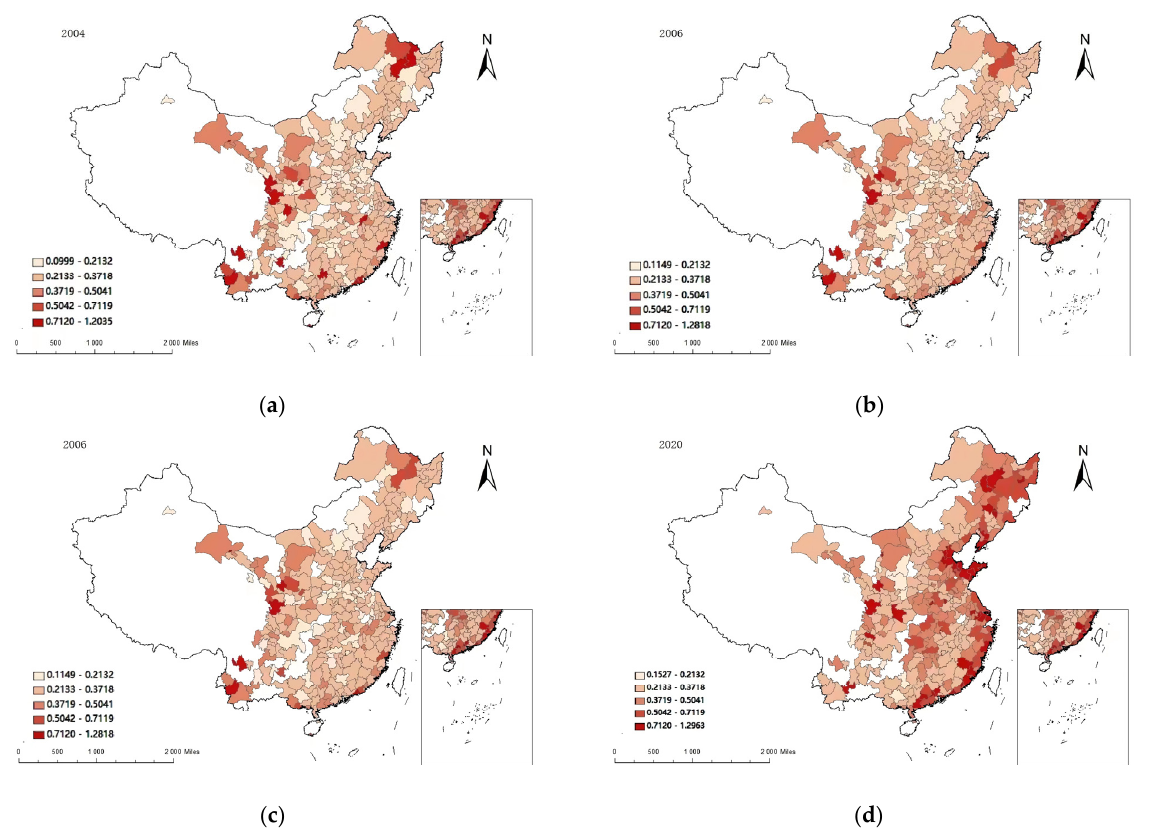
Figure 3. Distribution of land resource use efficiency in 4 years: ( a ) land resource use efficiency in 2004; ( b ) land resource use efficiency in 2006; ( c ) land resource use efficiency in 2016; ( d ) land resource use efficiency in 2020.